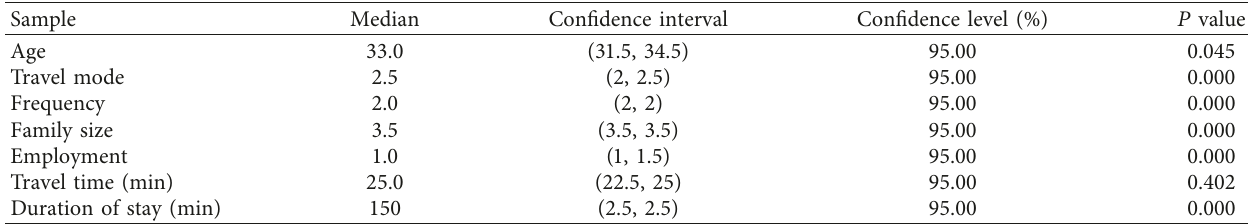
Table 4: Wilcoxon test.